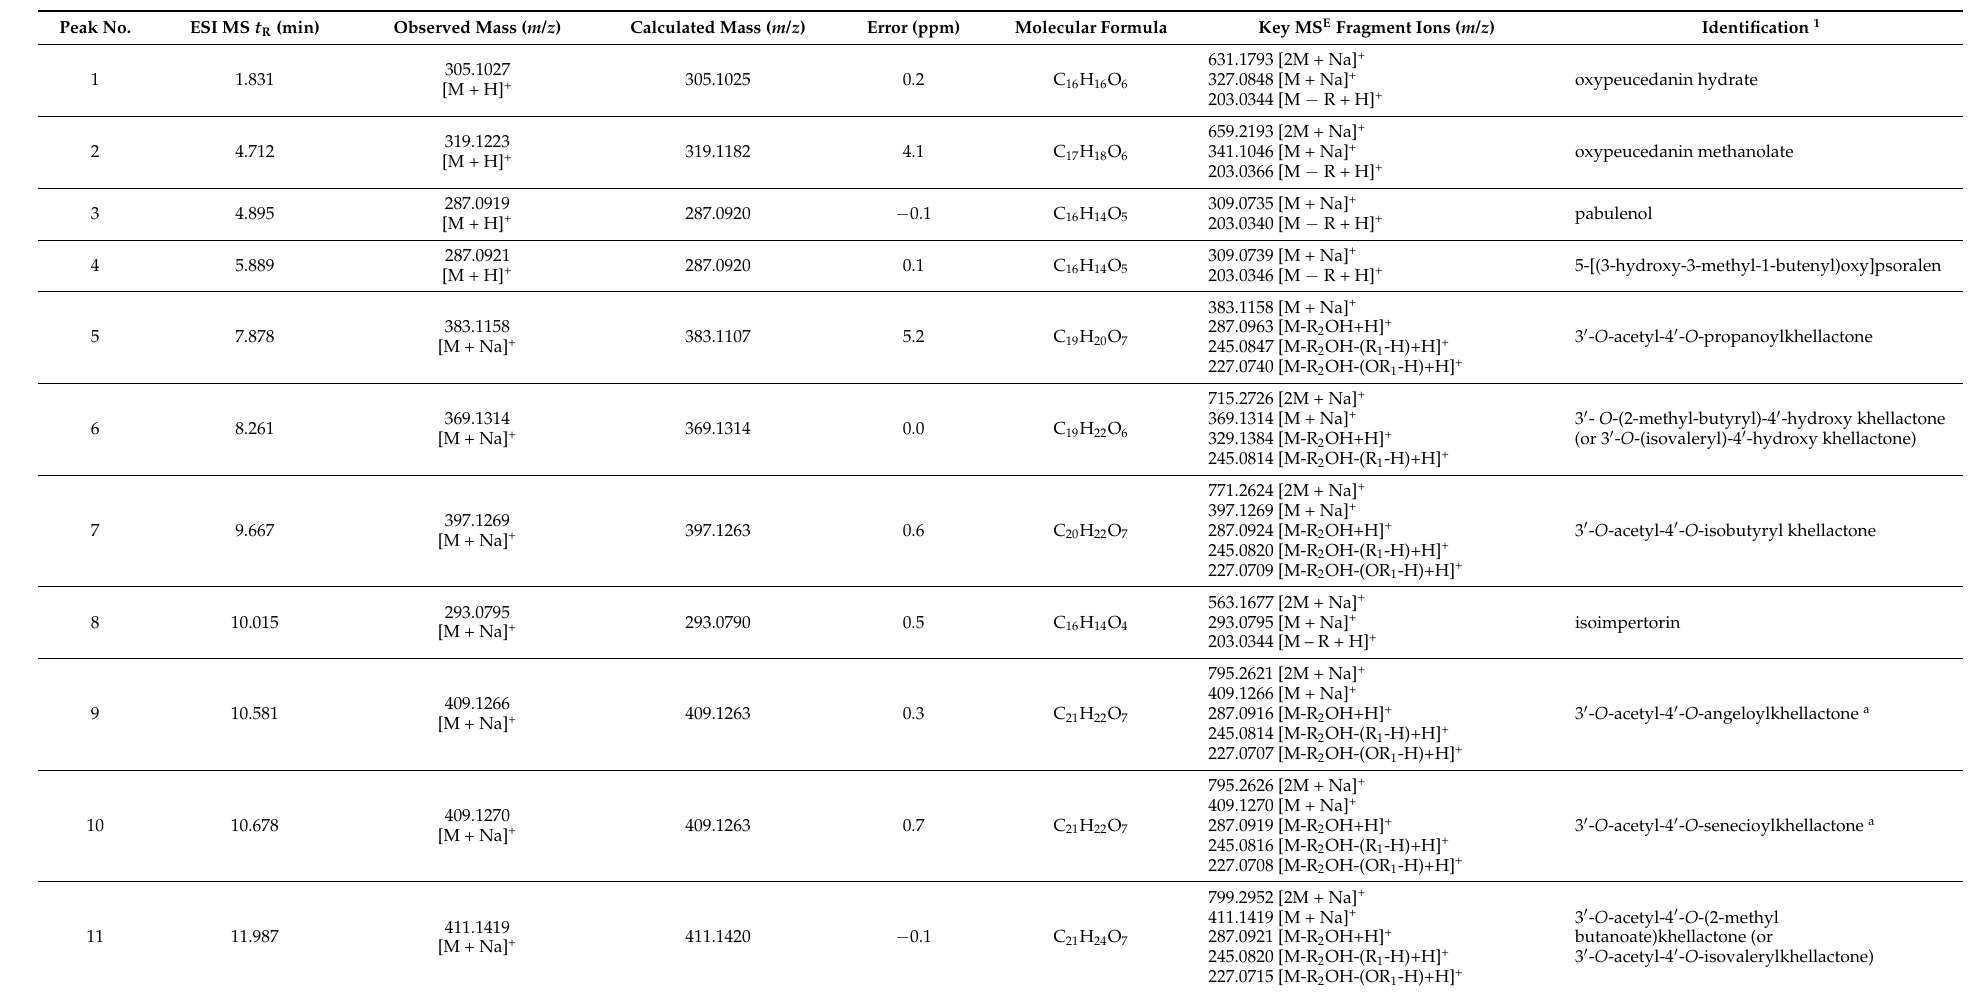
Table 1. Characterization and tentative identification of coumarins found in Peucedanum japonicum using UPLC-QTof MS. Peak